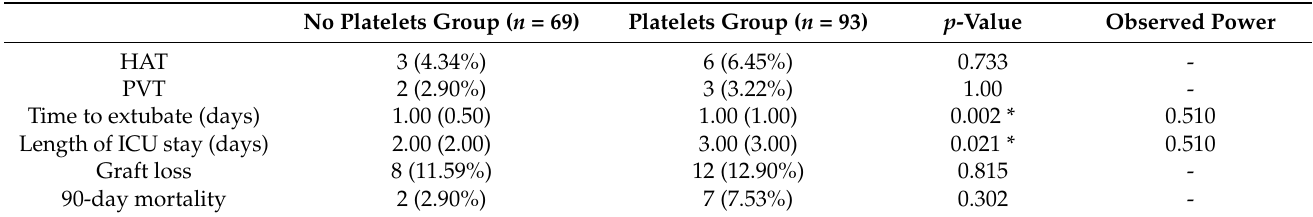
Table 5. Postoperative outcomes of LT patients categorised by intraoperative transfusion of platelets. No Platelets Group ( n = 69) Platelets Group ( n = 93) p -Value Observed Power